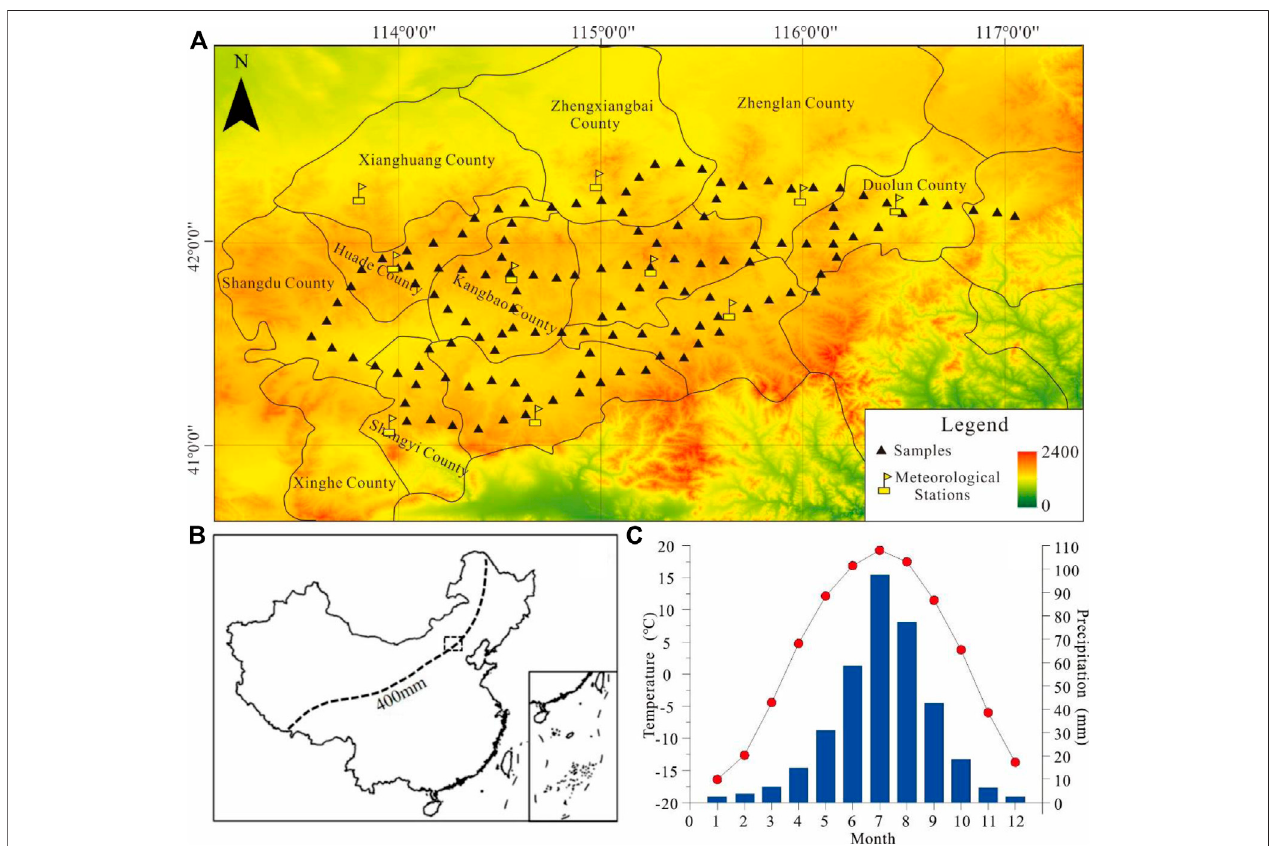
TABLE 1| Climatic conditions oftheBashang area,including theMATand MAP,calculatedbasedon meteorologicaldatabetween 1960and 2018fromten meteorological stations in the Bashang area obtained from the China Meteorological Data Sharing Service System. Meteorological Station Longitude Latitude Annual Precipitation